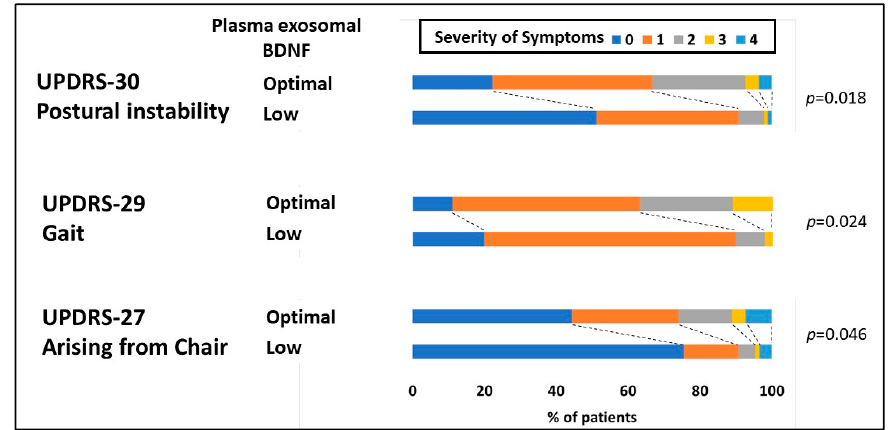
Table 2. Unified Parkinson’s Disease Rating Scale ( UPDRS) scores of patients with PD categorized into four groups based on the quartile (Q1 to Q4, low to high) for the plasma exosomal brain-derived neurotrophic factors (BDNF) level.